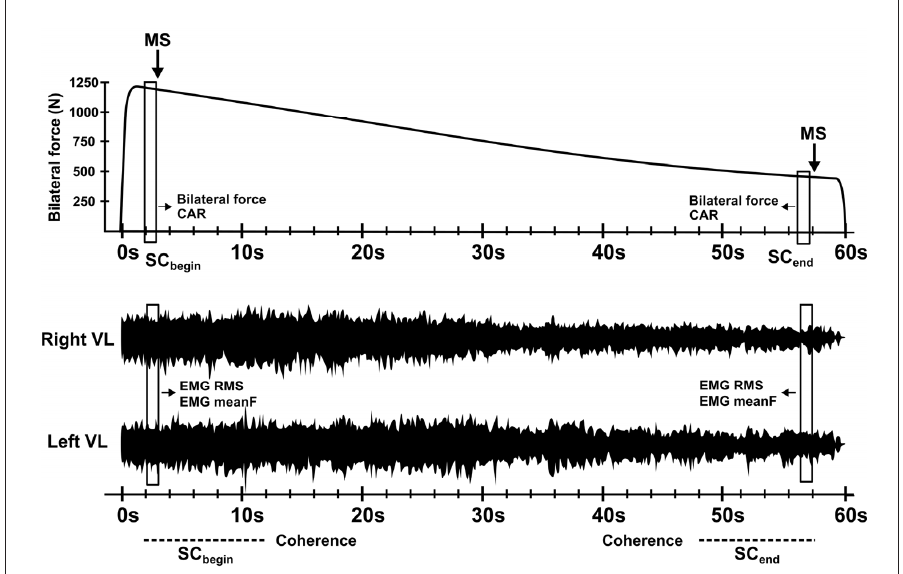
Figure 1. Experimental pro-